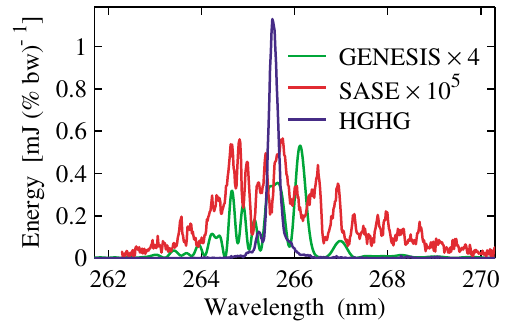
FIG. 10. (Color) Single shot HGHG spectrum for 30 MW seed (blue), single shot SASE spectrum measured by blocking the seed laser (red), and simulation of the SASE spectrum after 20 m of NISUS structure (green). The average spacing between spikes in the SASE spectrum is used to estimate the pulse